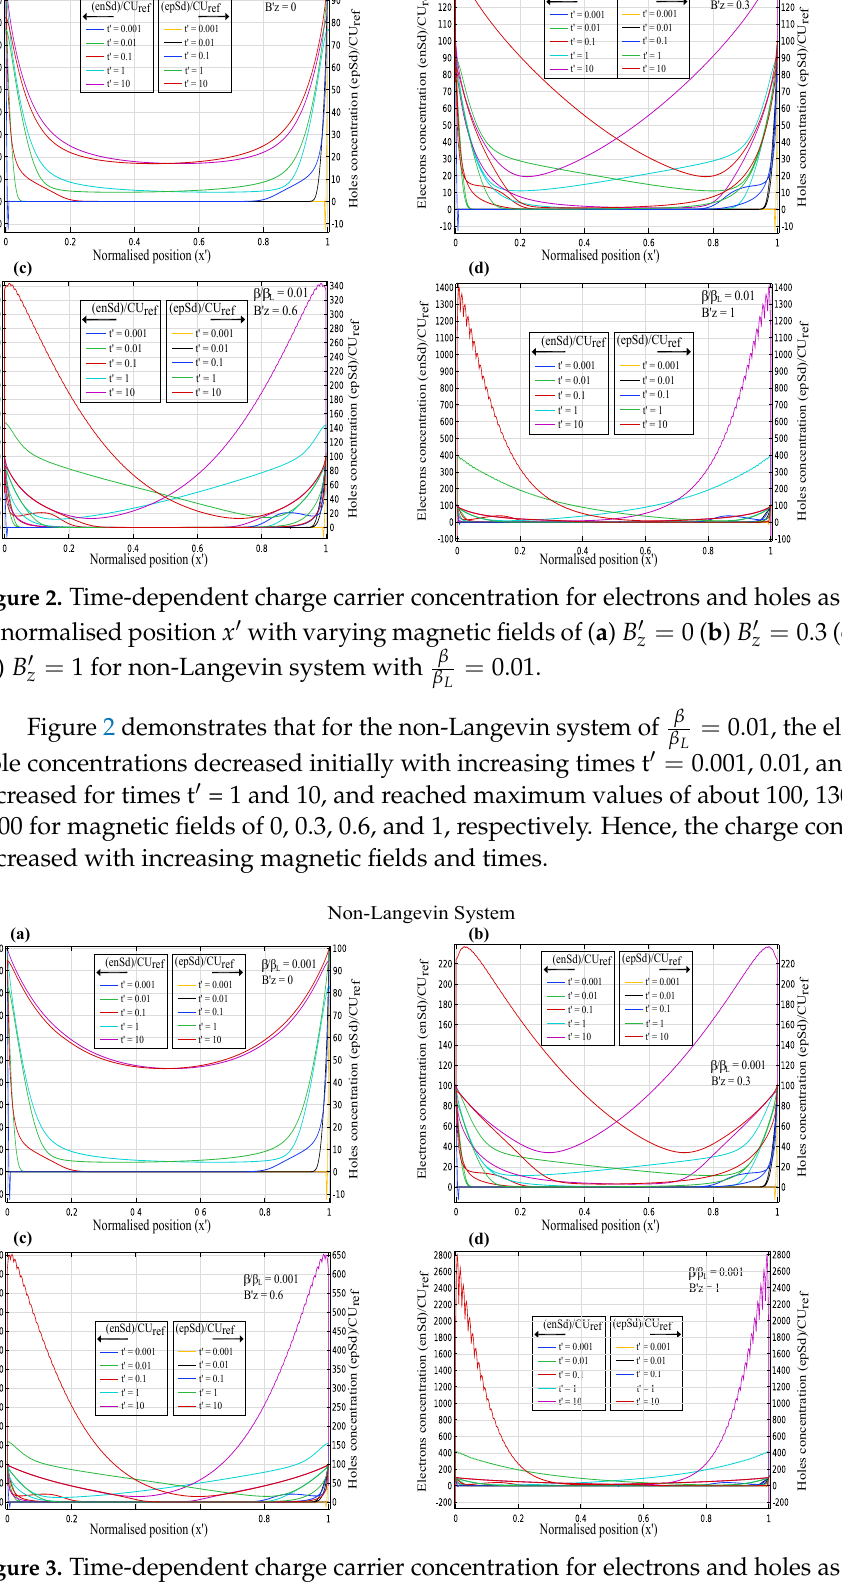
= 0 ( b ) B (cid:48) = 0.3 ( c ) B (cid:48) = 0.6 z z z = β L